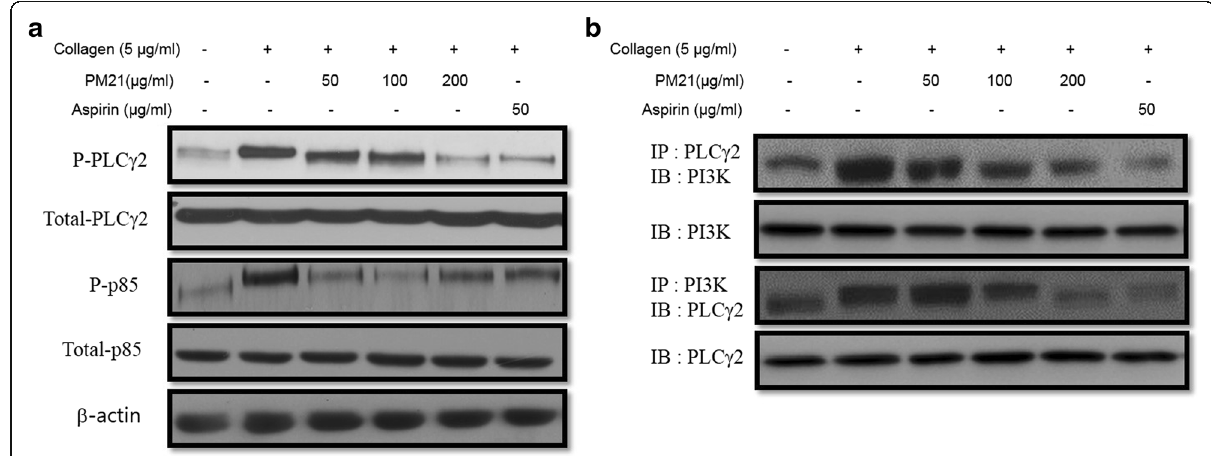
Fig. 6 Effects of PM21 on collagen-induced PLC γ 2 and PI3 K activation. Rat platelets in the presence of EGTA were incubated with PM21 and then stimulated with collagen. a Lysates from the platelets treated with either PM21 (50, 100, 200 μ g/mL) or aspirin (50 μ g/mL) were immunoblotted to detect the expression levels of PLC γ 2 and PI3 K (p85) proteins. b Platelet lysates were immunoprecipitated by incubating overnight with anti-PI3 K or anti-PLC γ 2, and then further incubated with protein A-Sepharose (PAS). Precipitated proteins were separated by SDS-PAGE and immunoblotted to detect phosphotyrosine residues. Equivalent protein loading was verified by reprobing for PLC γ 2 and PI3 K (p85). IP and IB in the diagram represent Immunoprecipitated and Immunoblotted,